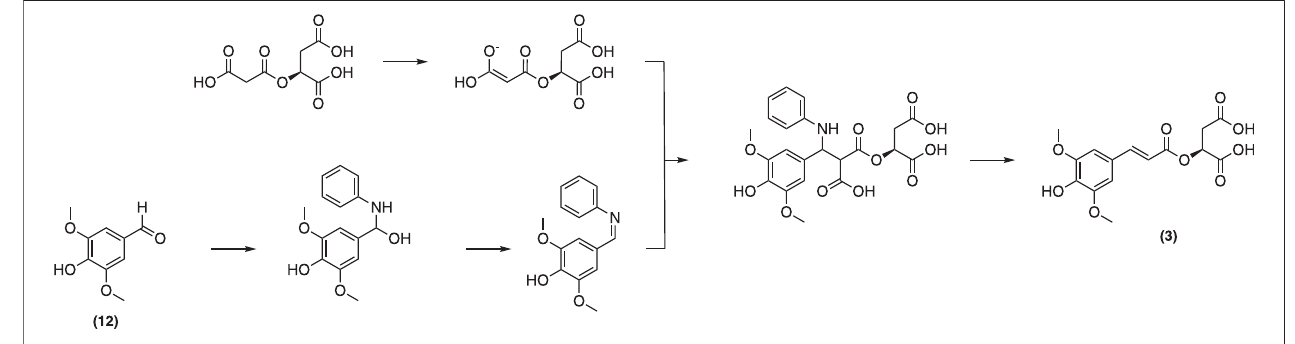
FIGURE 15 | Synthesis of sinapoyl malate described by Peyrot et al.